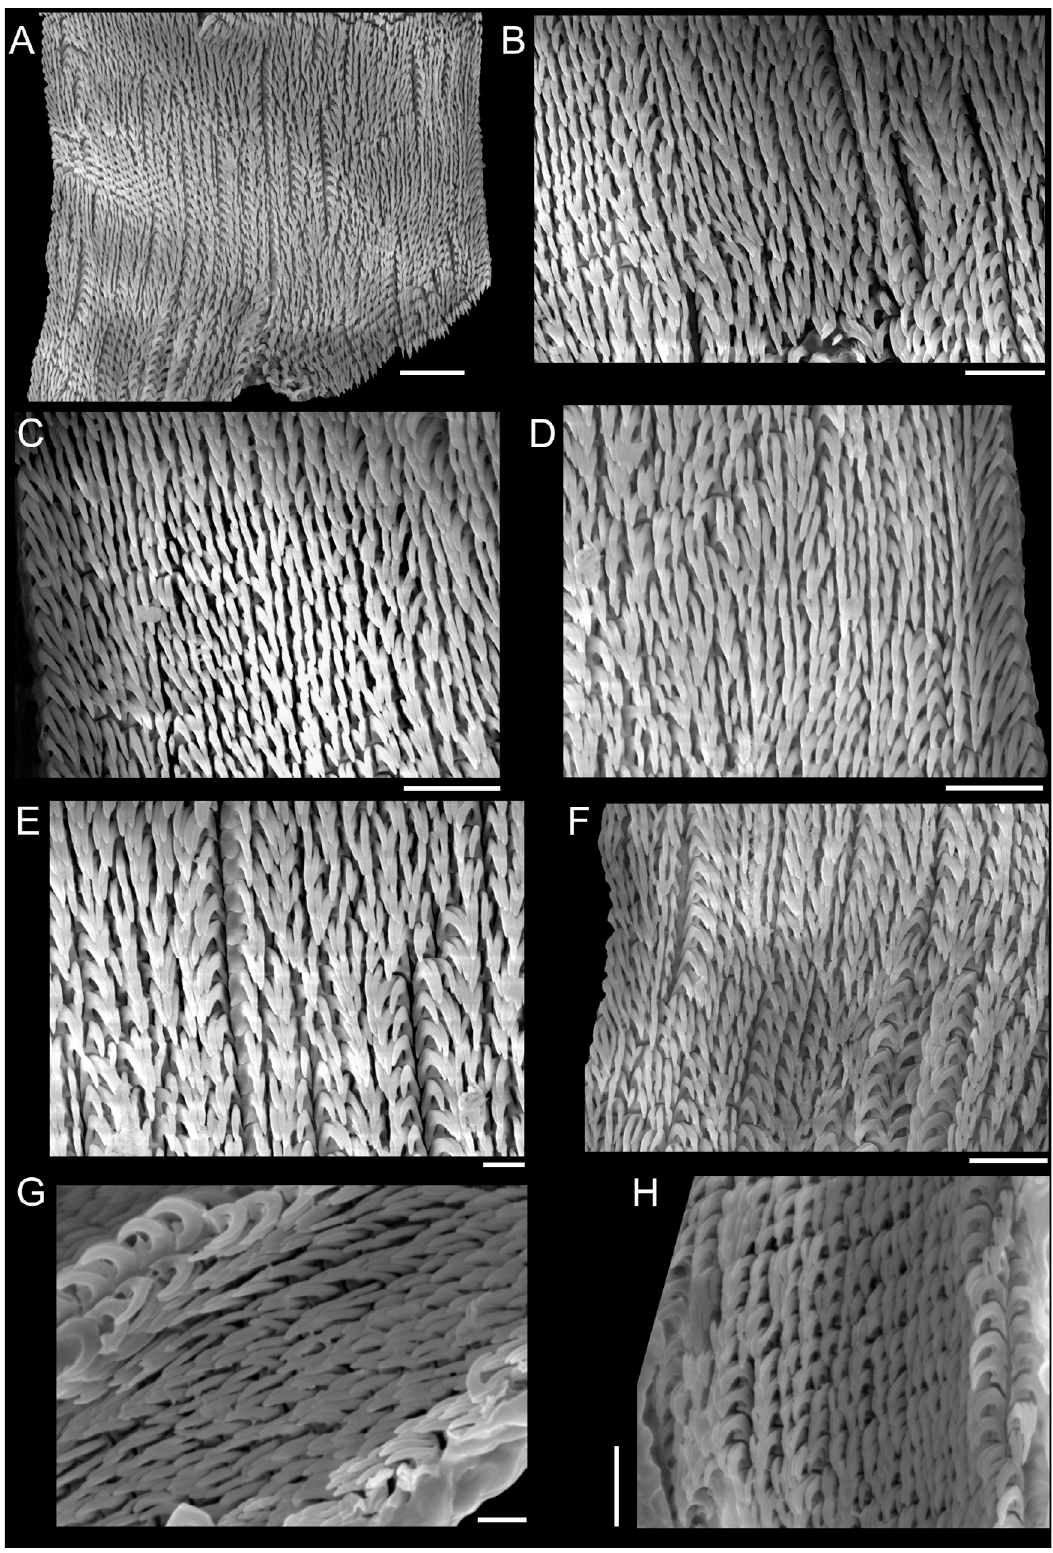
Fig. 11. Iniforis pseudothomae Rolán & Fernández-Garcés, 1993, radula. A–F . MZSP 100957. G–H . MNRJ 32881. Scale bars: A = 10 µm; B–D, F, H = 5 µm; E, G = 2